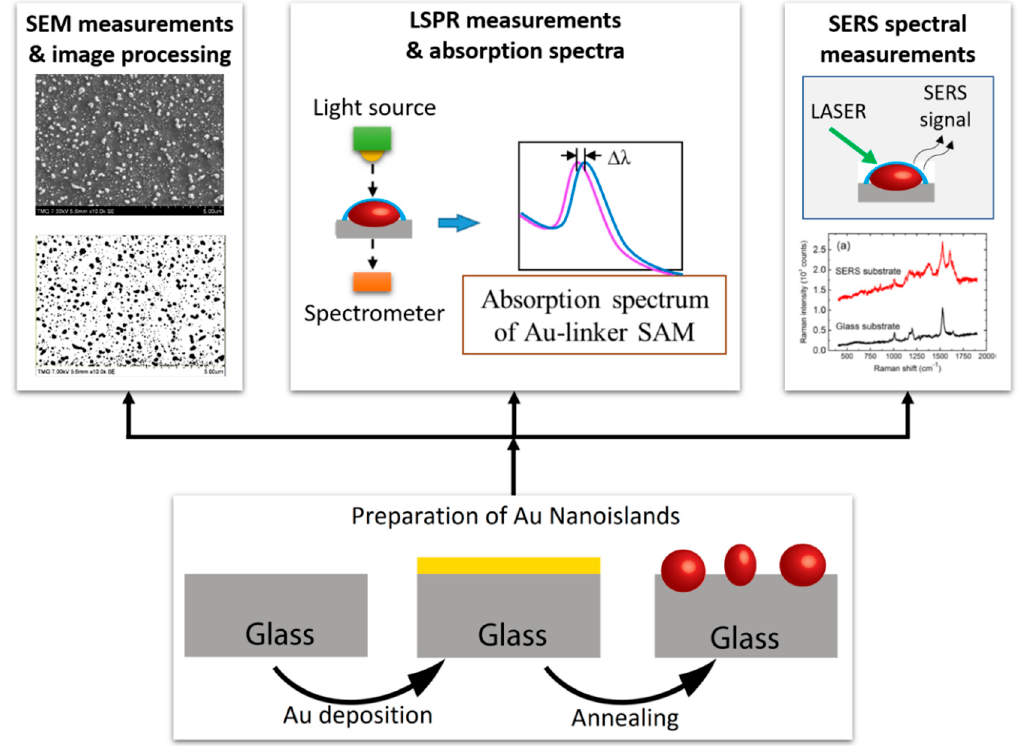
Figure 5. Localized surface plasmon resonance (LSPR) and SERS sensing applications of nano-islands.